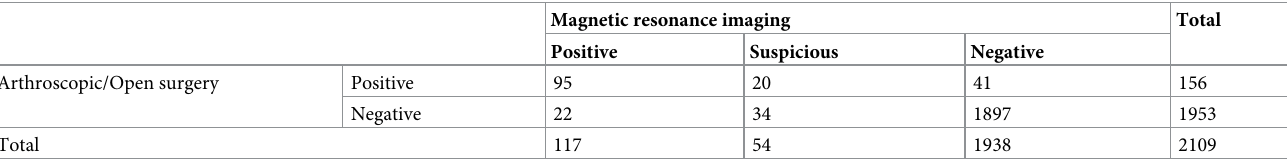
Table 2. Outcomes for MRI examination and arthroscopic/open